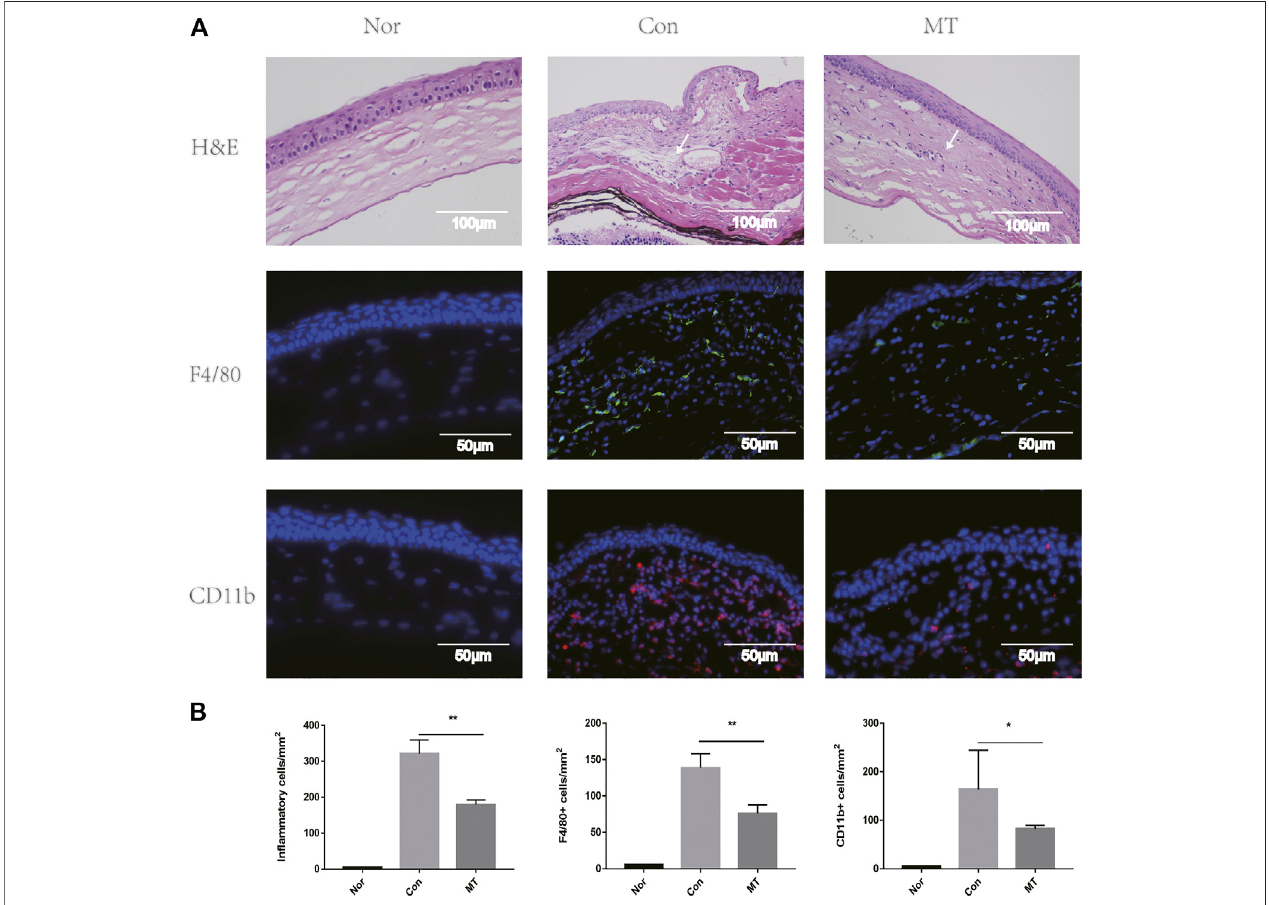
FIGURE 2 | MT inhibits in fl ammatory cells, F4/80, and CD11b recruitment. (A) At day 9 of transplantation, histopathology revealed less in fl ammatory cell (white arrows) in fi ltration in corneal grafts in the MT group (representative images for each group). Fluorescence images showing in fi ltration ofF4/80 and CD11b in the graftsof each group at day 9. Corneal sections were stained with immuno fl uorescent antibodies for positive cells, as shown (Scale: 50 µm). (B) Count of positive cells in corneal grafts of each group on day 9 ( n (cid:1) 3 per group). (Nor: Normal group; Con: control group; MT: treated with MT). * p < 0.05, ** p < 0.01, *** p < 0.001.